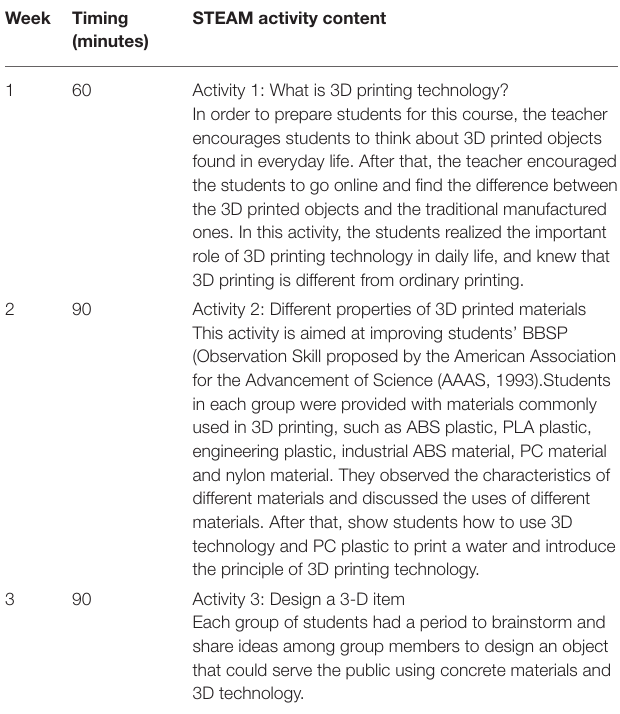
TABLE 1 | The procedure of the proposed STEAM